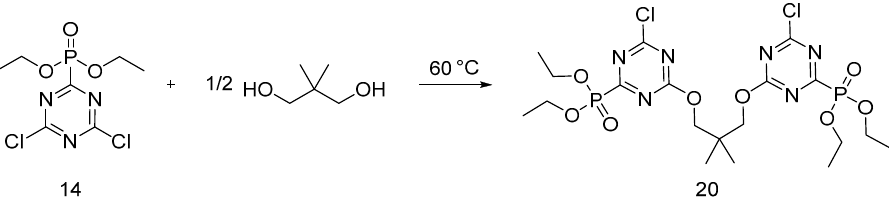
Figure 12. Schematic synthesis of oligomer ( 20 ).